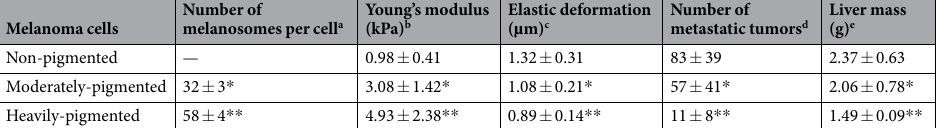
Table 1. Numerical values of the obtained results. a Average number (mean ± s.d.) of melanin granules determined by EPR analysis; b Average value (mean ± s.d.) of the Young’s modulus determined by AFM measurements; c Average value (mean ± s.d.) of elastic deformation determined based on mechanical analysis; d Average number (mean ± s.d.) of metastatic tumors found in the livers of mice during autopsy; e Average value (mean ± s.d.) of liver masses determined during autopsy. * Statistically significant vs. non-pigmented cells;